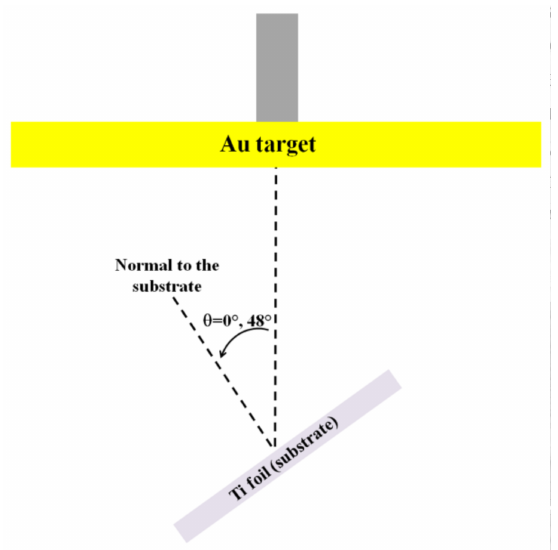
Figure 1. Scheme of the experimental setup for the Au depositions on Ti in normal condition ( θ = 0 ◦ ) or in oblique condition ( θ = 48 ◦ ). Table 1. Summary of the deposition conditions (deposition angle and deposition time) of the Au films and resulting thickness of the Au films. The first column reports the names assigned to the samples. Sample Deposition Angle θ ( ◦